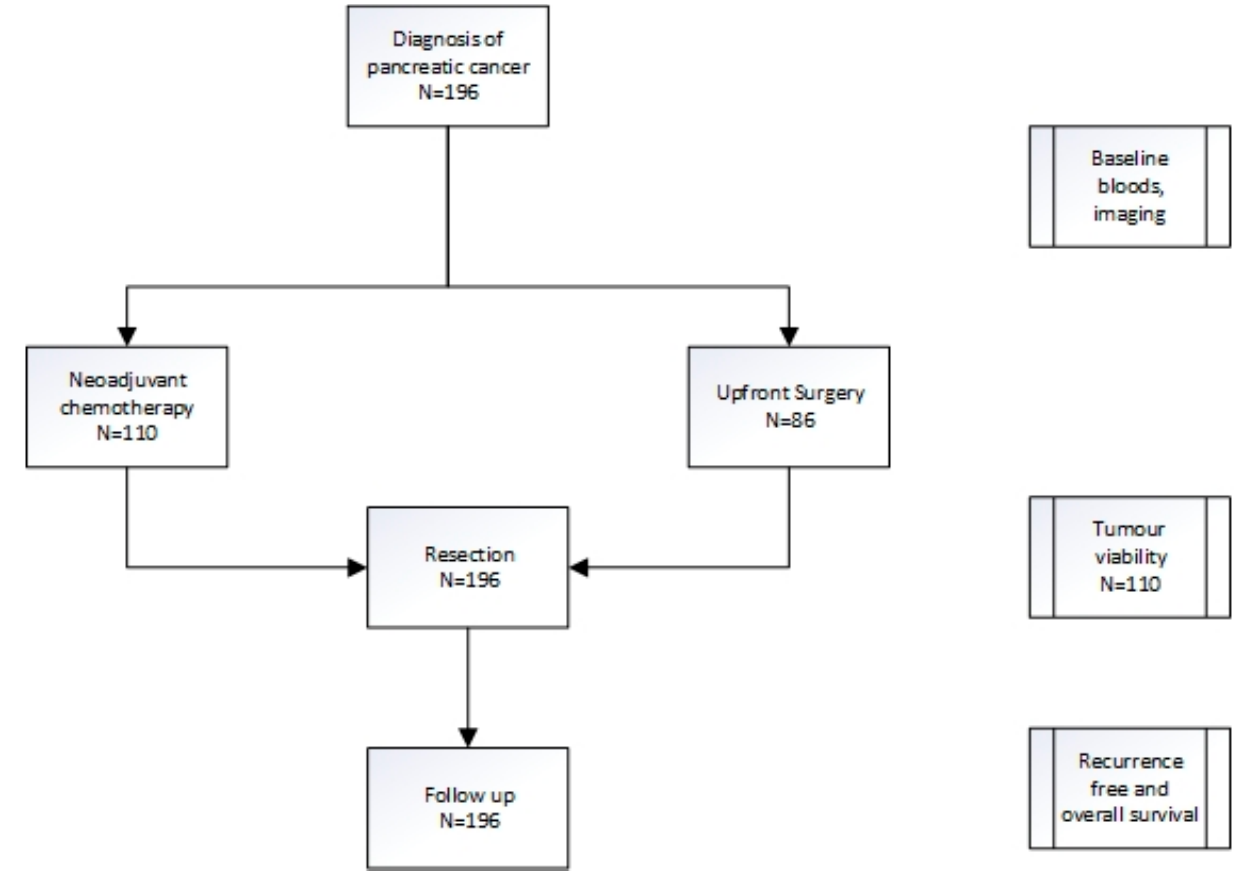
Figure 1. Treatment pathway for pancreatic cancer